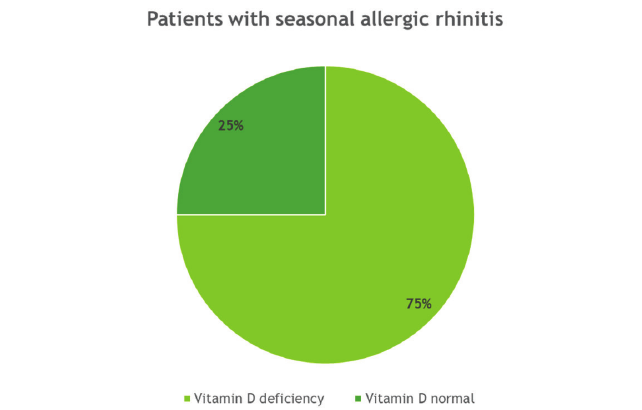
Figure 5a - correlation the nasal congestion with vitamin D concentration